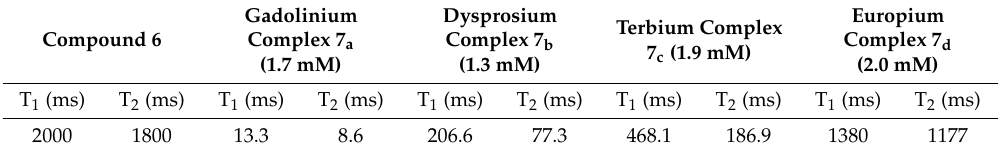
Table 2. Fluorine T 1 and T 2 relaxation times for each synthesized